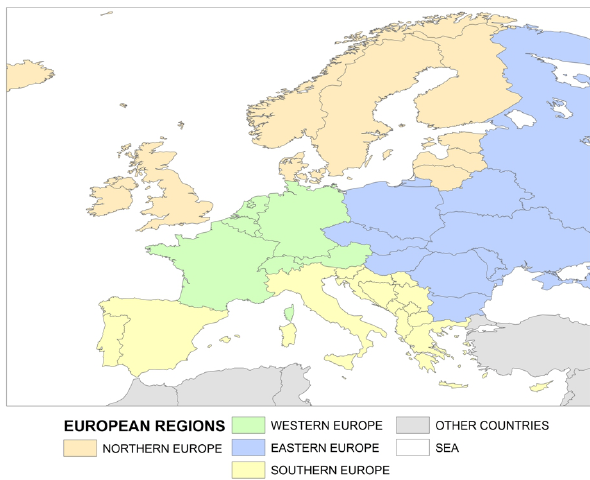
Fig. 1. Modelling domain and the regional European grouping used by the United Nations Statistics